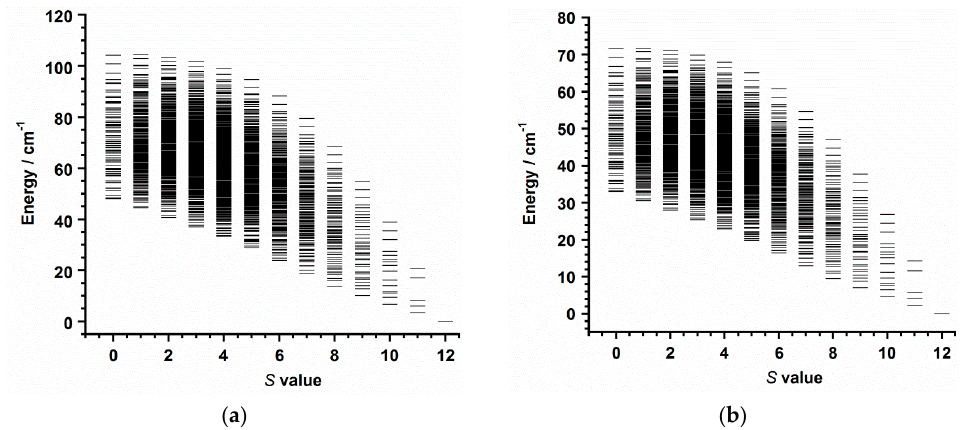
Table 2. Selected magneto-structural parameters for compounds 1 and 2 .